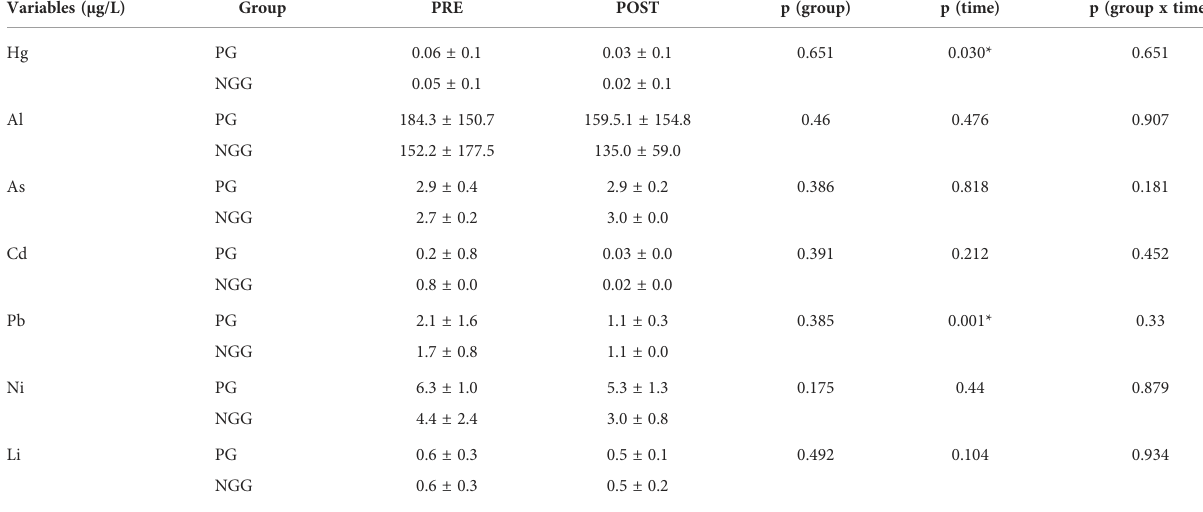
TABLE 3 Mean ± standard deviation of PRE and POST metal values 14 weeks of combined training (PG: n 24; NGG: n 24). Variables (µg/L)